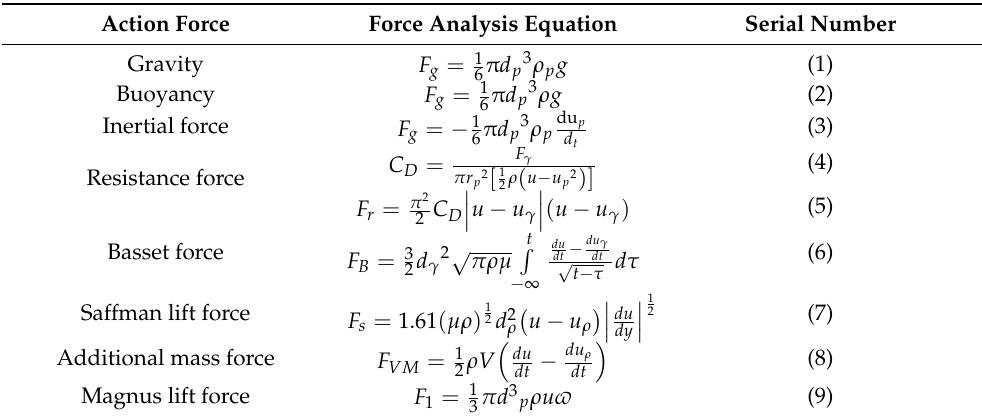
Table 1. Force analysis equations for particle